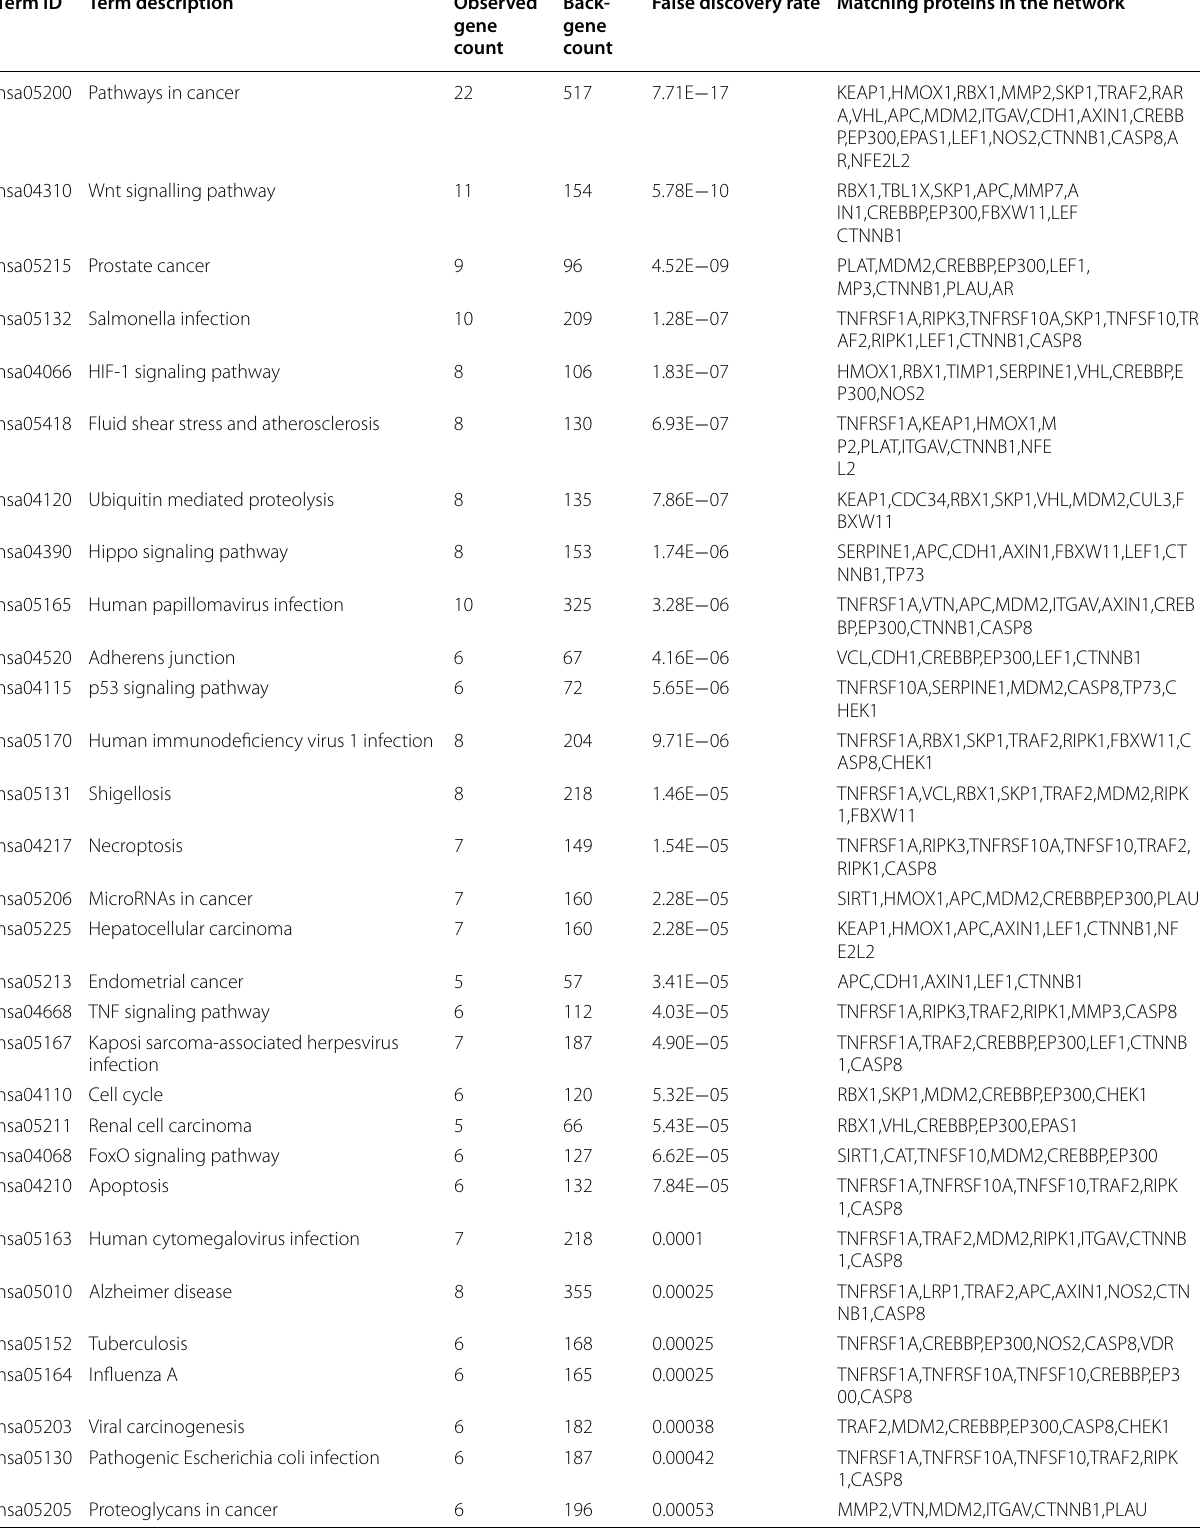
Table 2 Enrichment analysis of modulated proteins by the reported quercetin derivatives Term